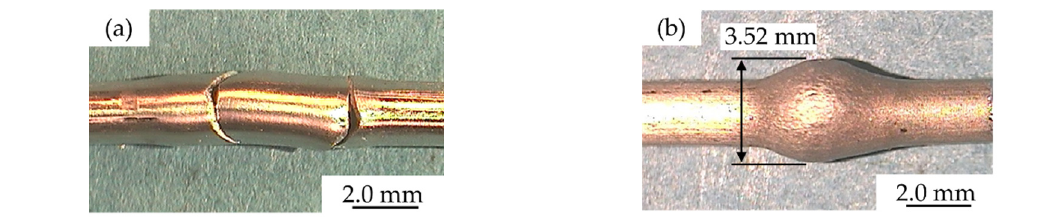
Figure 7. Expansion behavior of the tube at R.T and 250 °C: ( a ) fractured tube at R.T; ( b ) expanded tube at 250 °C.